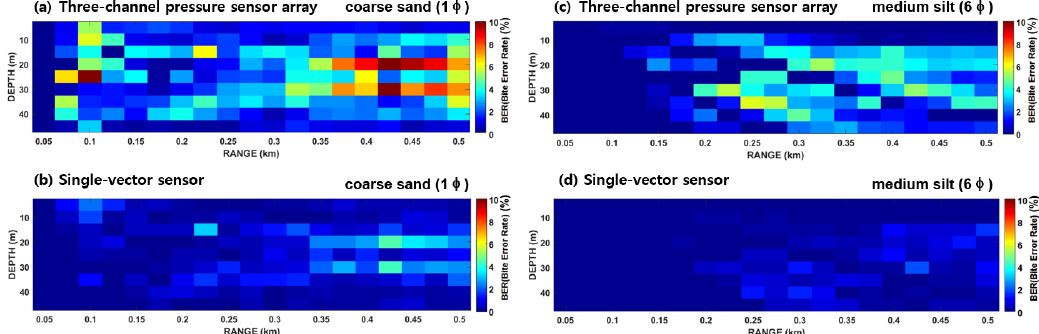
Figure 3. Communication performance (BER estimates) as a function of receiver position. Left and right plots are for coarse sandy and silty bottoms, respectively. Upper and lower plots correspond to the performance results for a three ‐ channel pressure sensor array and a single ‐ vector sensor, respectively.